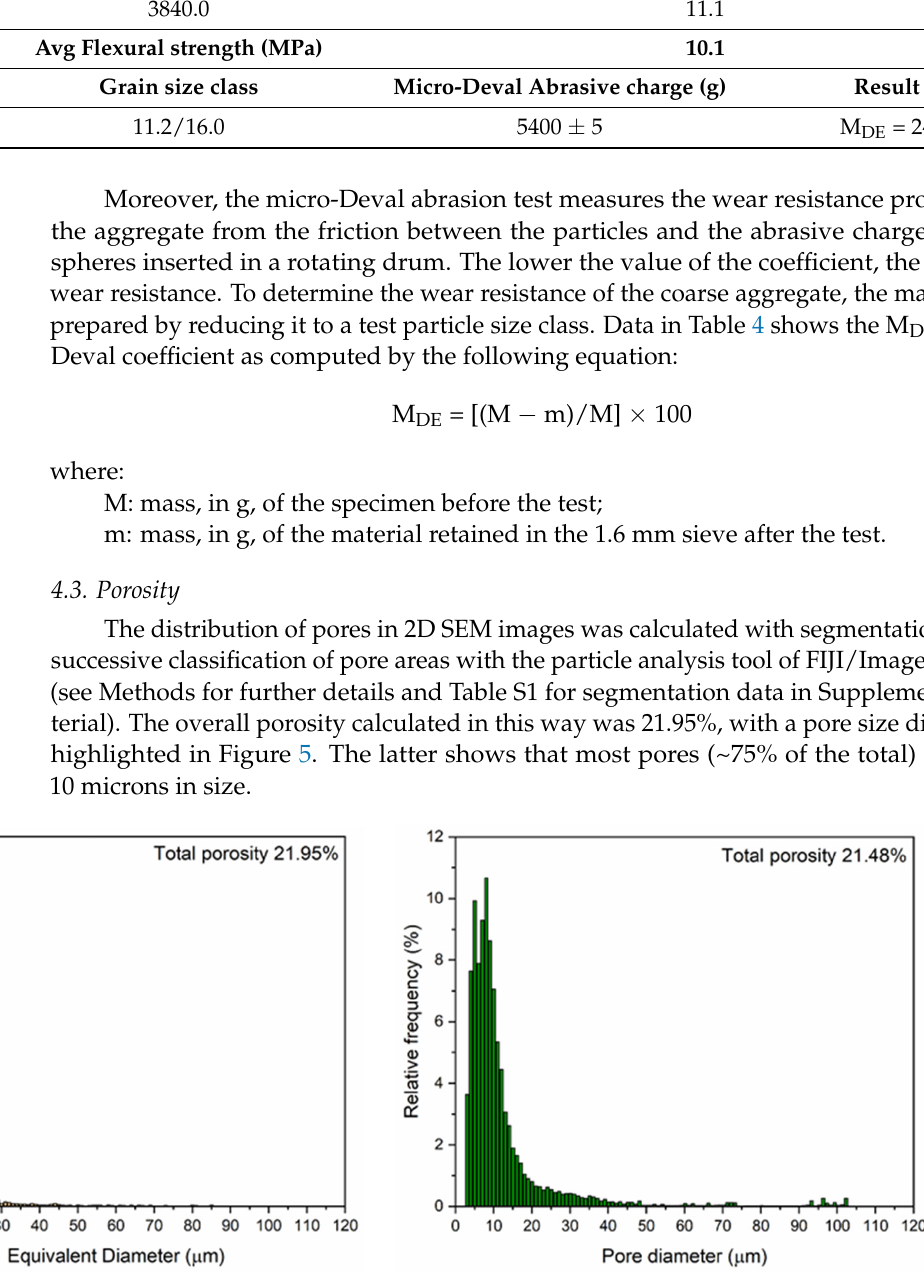
Figure 5. Pore size distribution of CFM sample, computed in 2D from SEM images ( left ) and in 3D with local thickness algorithm of the sampled subvolume using micro-CT Versa scan ( right ).